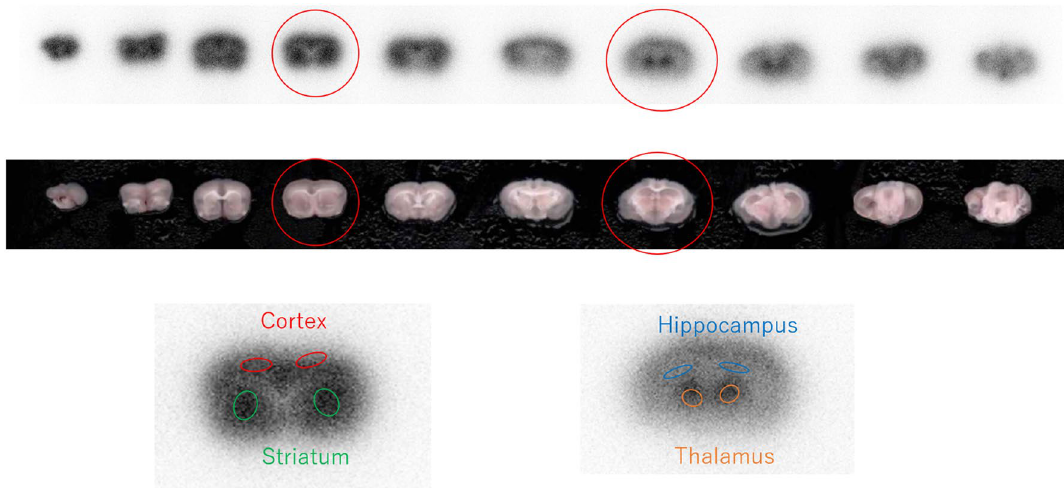
Figure 5. Brain 18 F-FDG autoradiography image. ROIs were placed on 18 F-FDG ARG image to cover the cortex, striatum, hippocampus, and thalamus on the left and right hemispheres. The cortex is encircled in red, the striatum in green, the hippocampus in blue, and the thalamus in